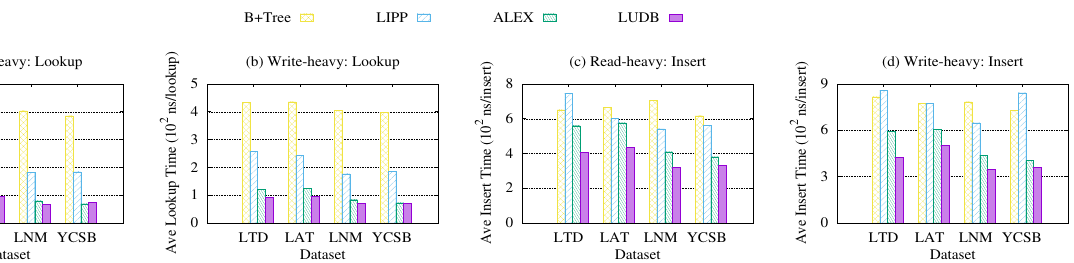
Figure 6. Average lookup and insert time: comparisons with other